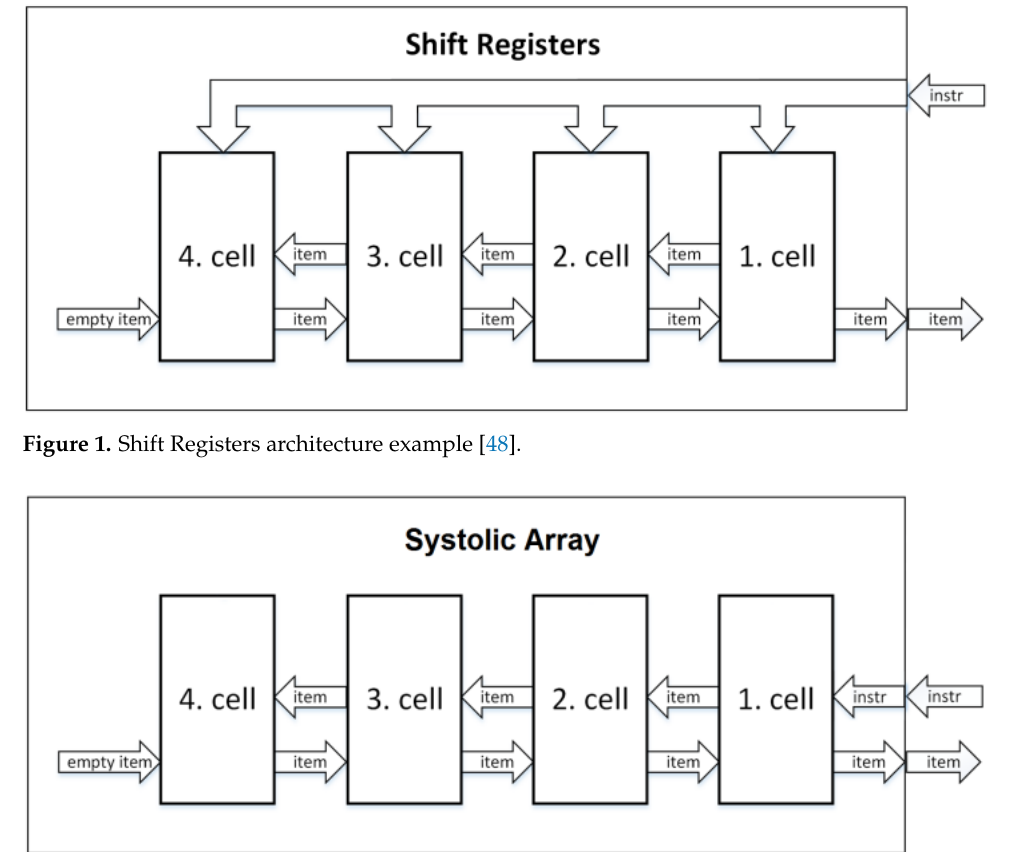
Figure 1. Shift Registers architecture example [48].